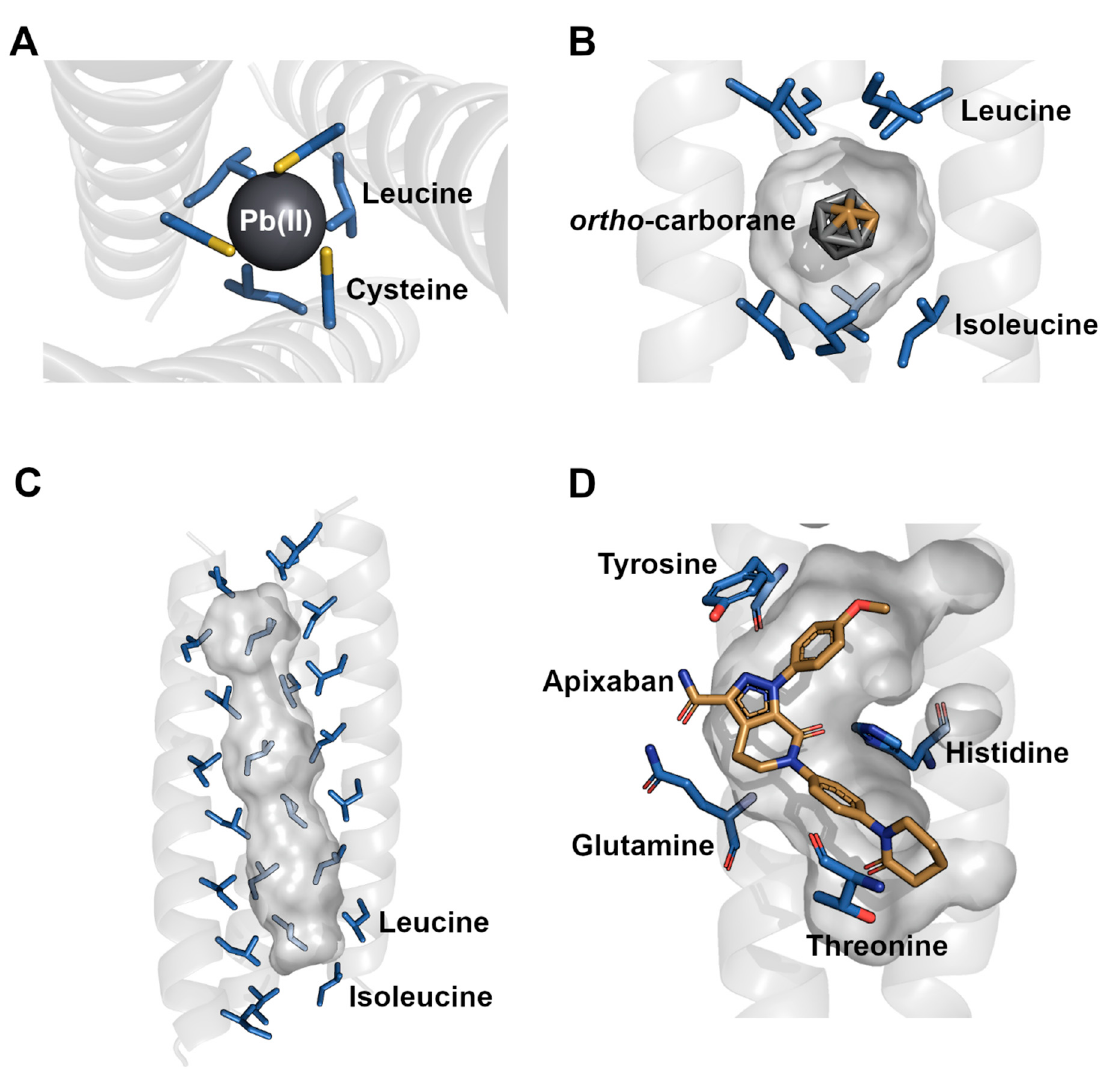
Figure 2. Selected structural models of cavity residues and their interactions with bound ligands. ( A ) The Pb(II)C 3 (PDB: 6MCD) coiled coil coordinates a Pb(II) atom via cysteine and leucine residues. The coordination is further stabilized by a hydrogen bond network with bound water molecules between the helices. ( B ) RHCC (PDB: 7R6H) in complex with ortho -carborane. The nonpolar ligand is stabilized in the hydrophobic cavity by the nonpolar side chains of leucine and isoleucine. ( C ) Cavity space of the CC-Hex2 (PDB: 4PN9) nanotube. The elongated hydrophobic cavity is constructed by alternating leucine and isoleucine side chains which span the entire hexameric nanotube. Three helices were omitted for improved visualization. ( D ) Apixaban binds into the central cavity of ABLE (PDB: 6W70). The polar ligand is stabilized by multiple polar residues including tyrosine, histidine, glutamine and threonine.